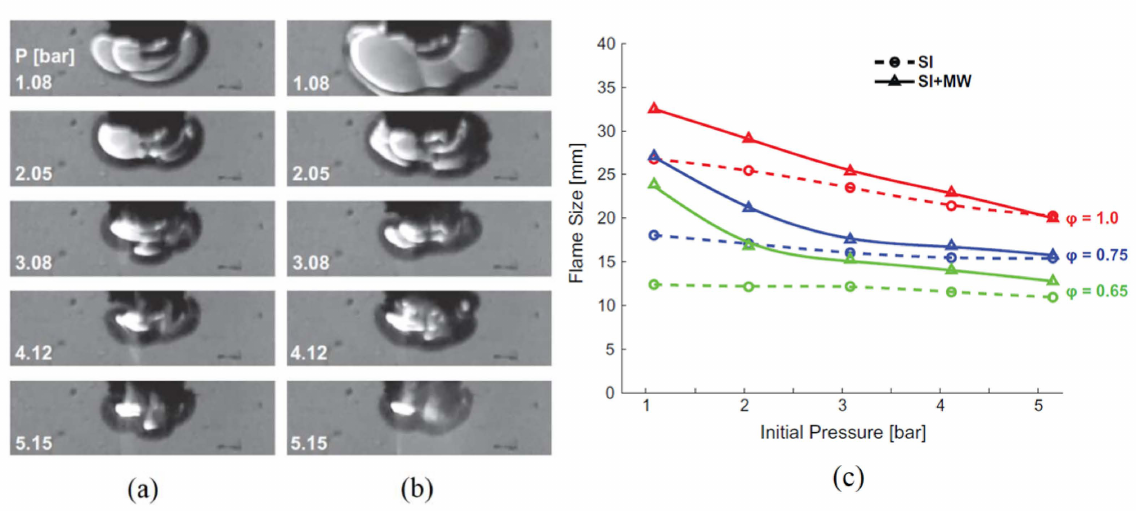
Figure 12. Schematic of ( a ) a conventional spark plug, ( b ) a microwave-assisted plasma ignition ( ∅ :0.75) and ( c ) a flame kernel size result